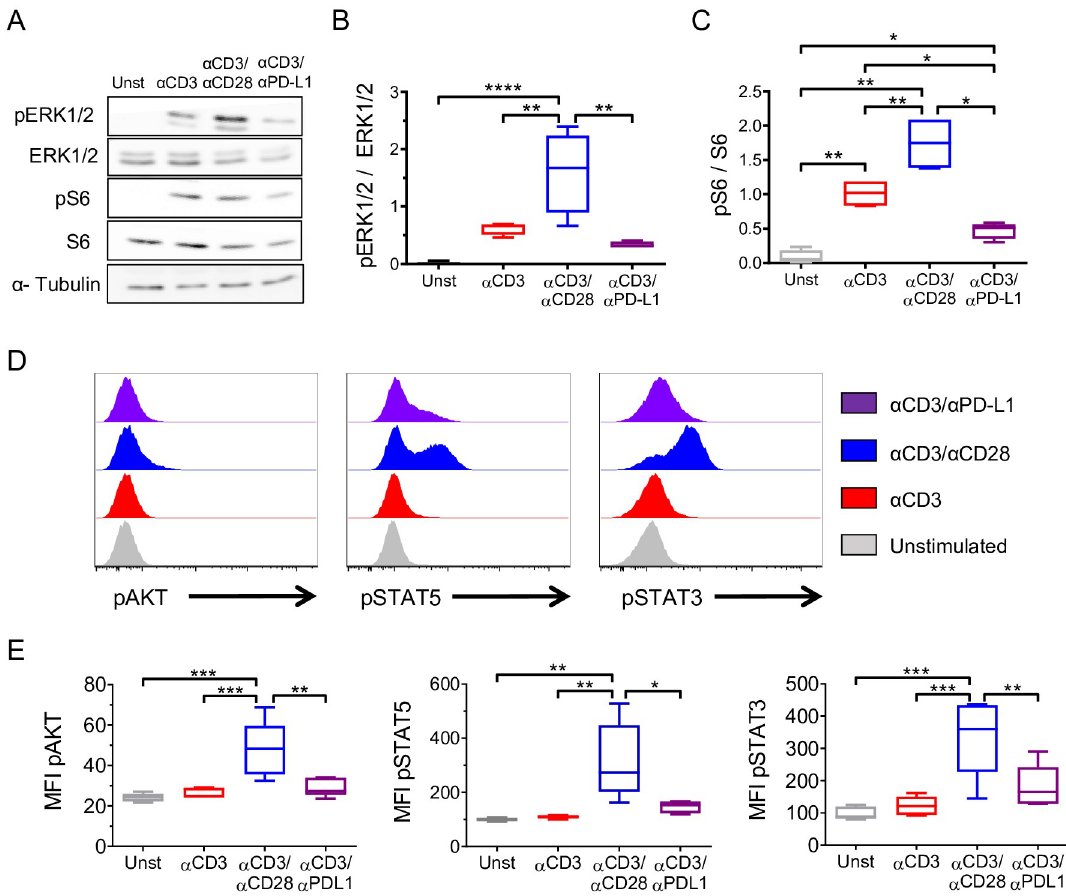
Fig 5. Cosignaling through PD-L1 promotes iTreg conversion by modulating AKT/mTOR/S6 and TCR/MAPK pathways. ( A ) Representative immunoblot of pERK1/2, ERK1/2, pS6, and S6 in memory T cells upon 15 min of activation under the indicated conditions. α -Tubulin was used as loading control. Western blot quantification of ( B ) ERK1/2 (pERK1/2/ERK ratio) and ( C ) S6 (pS6/ S6 ratio) activation status are shown ( n = 6, 6 independent experiments). Data are represented using boxplots indicating the min and max and median; � P < 0.05, �� P < 0.01, ��� P < 0.001, and ���� P < 0.0001 by RM one-way ANOVA followed by Tukey multiple comparison. ( D ) Representative flow cytometry histograms showing the MFI of pAKT, pSTAT3, and pSTAT5 following 48 h of stimulation under the indicated conditions. ( E ) Quantification of pAKT, pSTAT5, and pSTAT3 MFI ( n = 6). Data are represented using boxplots indicating the min and max and median; � P < 0.05, �� P < 0.01, and ��� P < 0.001 by RM one-way ANOVA followed by Tukey multiple comparison test. Values for each data point can be found in S1 Data. Full gating strategies from representative plots are shown in S1 Gating Strategy. Full blots are available in S1 Raw Images. ERK1/2, total ERK; iTreg, inducible Treg; MAPK, mitogen- activated protein kinase; MFI, mean fluorescence intensity; pAKT, phospho-AKT; PD-L1, PD-1 ligand 1; pERK1/2, phospho-ERK1/2; pS6, phopho-S6; pSTAT3, phospho-STAT3; pSTAT5, phospho-STAT5; RM, repeated measures; S6, total S6; TCR, T cell receptor.